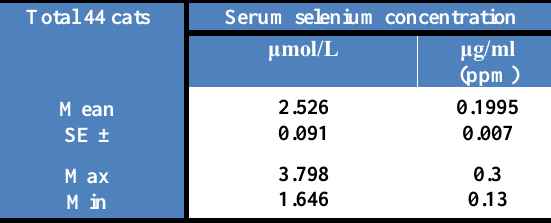
Table, 1: The mean and range of serum selenium concentration in cats.